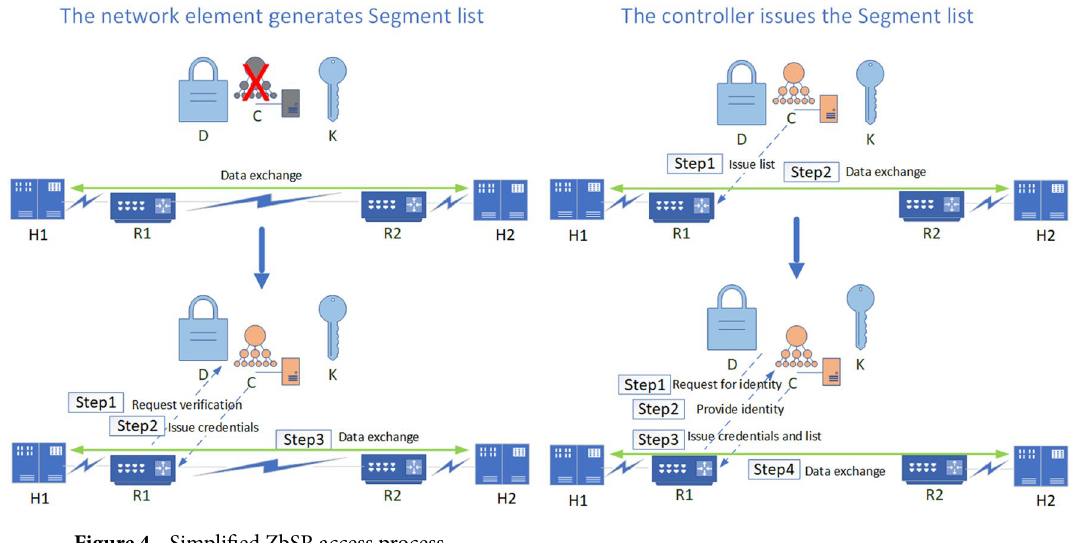
Figure 4. Simplified ZbSR access process.